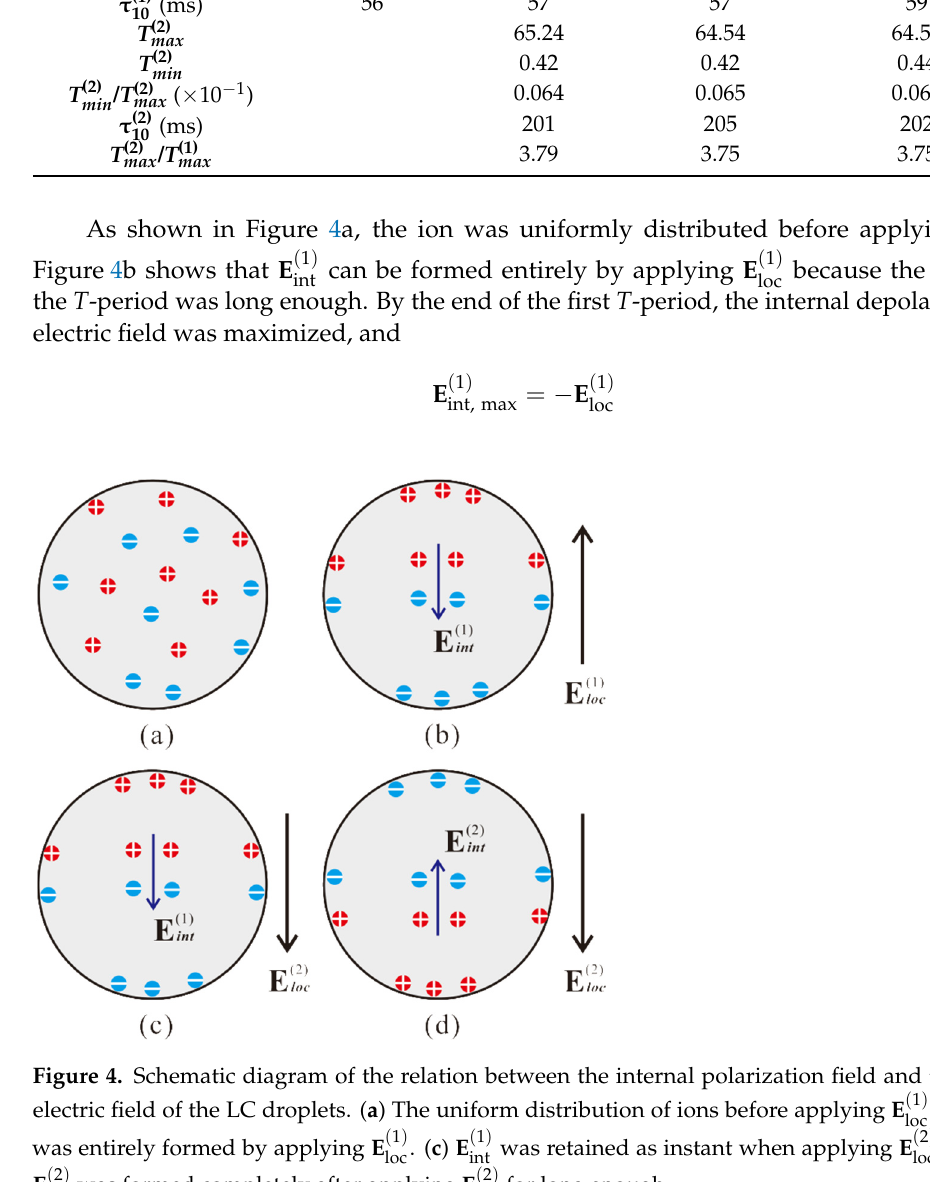
loc(1) int(1) ( 1 ) ( 1 ) ; ( b ) 𝐄 ; ( b ) E int loc loc(2) ( 2 ) and ( d ) and ( d ) loc